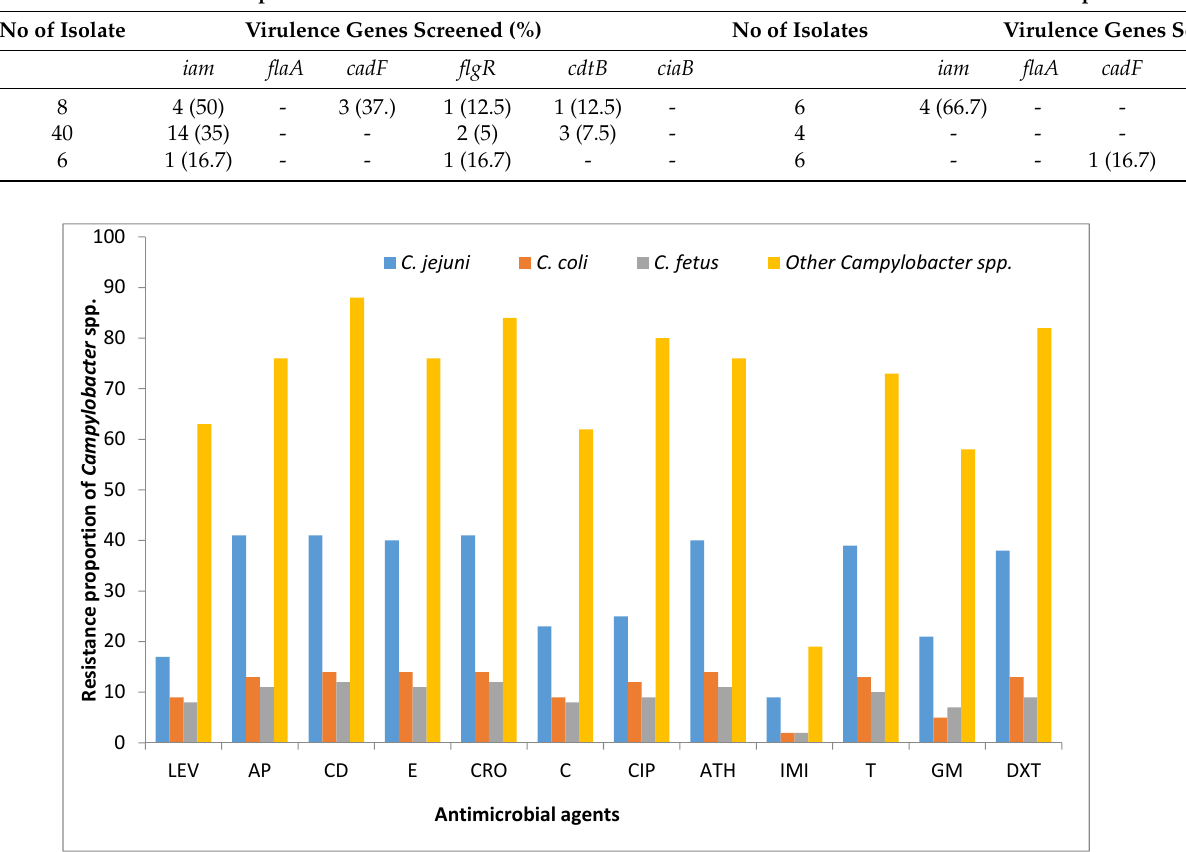
Table 2. Prevalence of virulence genes detected in Campylobacter species.